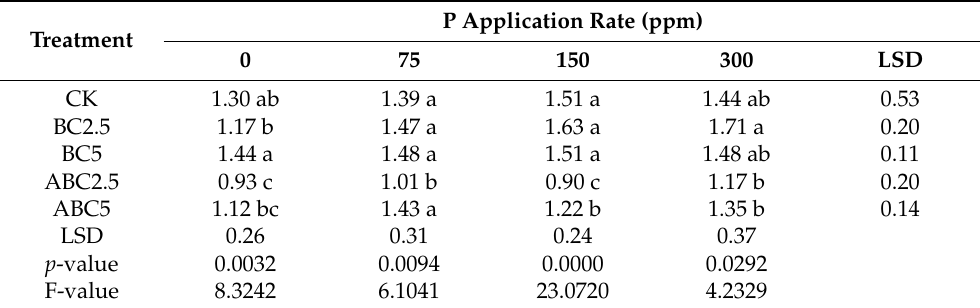
Table 8. Effects of BC and ABC applied at different rates with different P fertilizer application rates on plant P concentration (g kg − 1